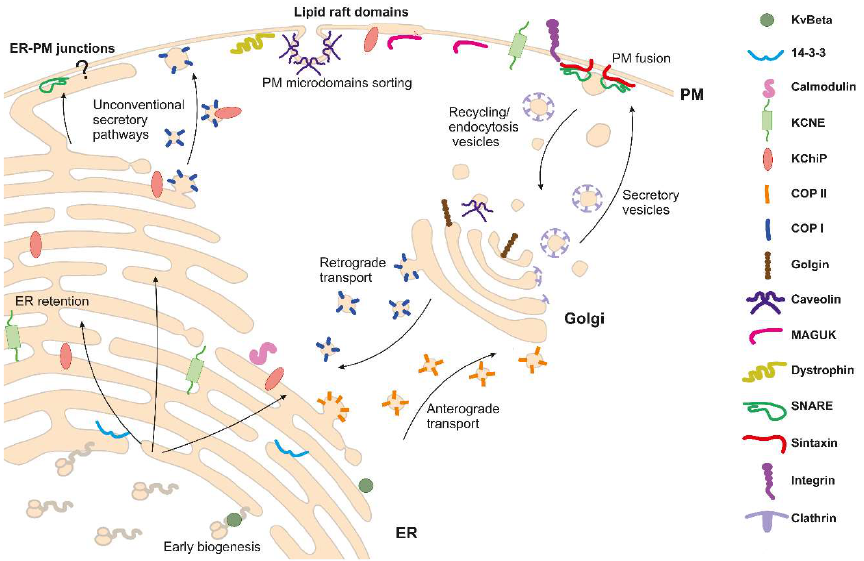
Figure 2. A schematic representation of traffic mechanisms and molecular associations of K + channels through the secretory pathway. Different shapes represent molecules (see list on the right) known to